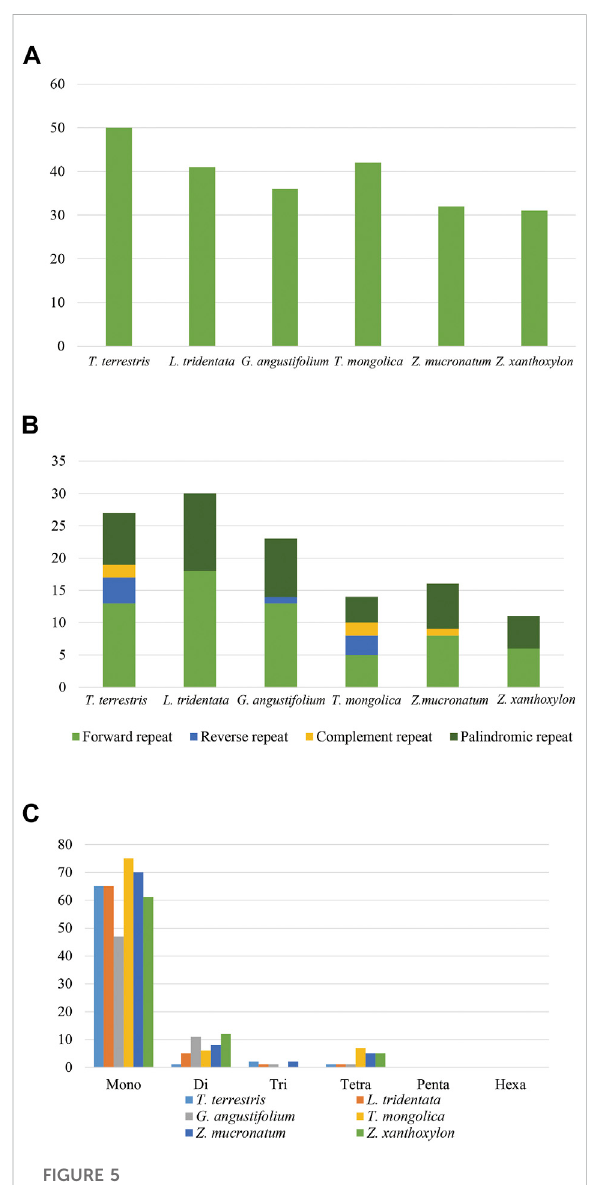
FIGURE 5 Numbers and types of repeat elements. (A) Tandem